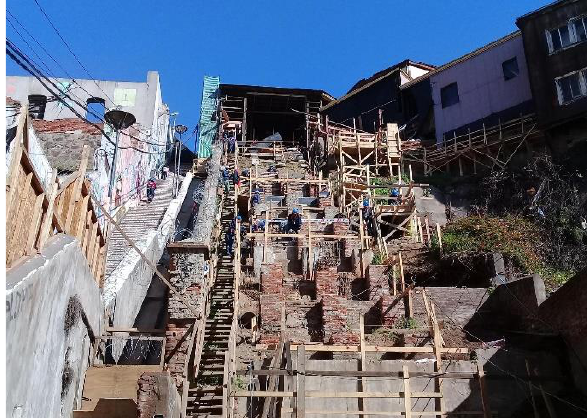
Figure 5. View of the railway at the Cordillera elevator.